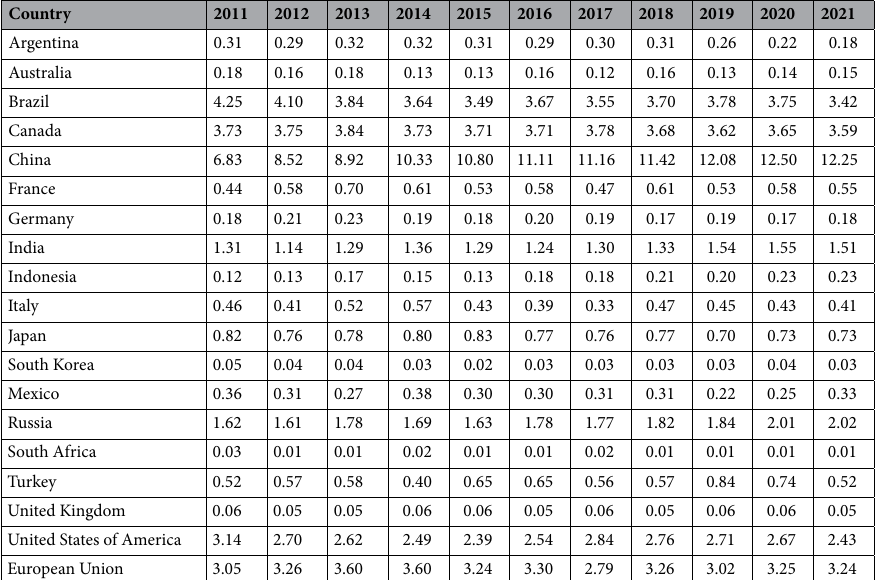
Table 9. Hydroelectricity Consumption Data of G20 Countries 47 . All consumption in exajoules.